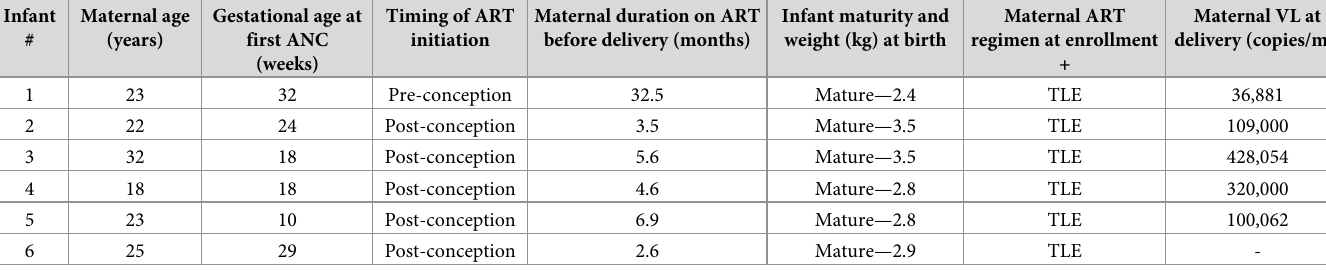
Table 5. Timing of ART initiation and maternal viral load at delivery for HIV-infected infants. Infant